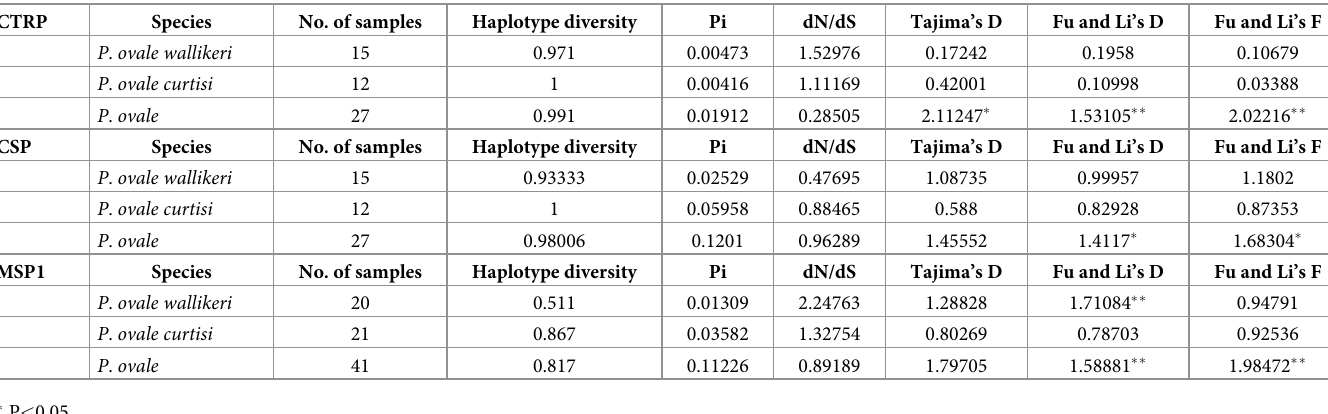
Table 2. Nucleotide diversity and natural selection in P . ovale